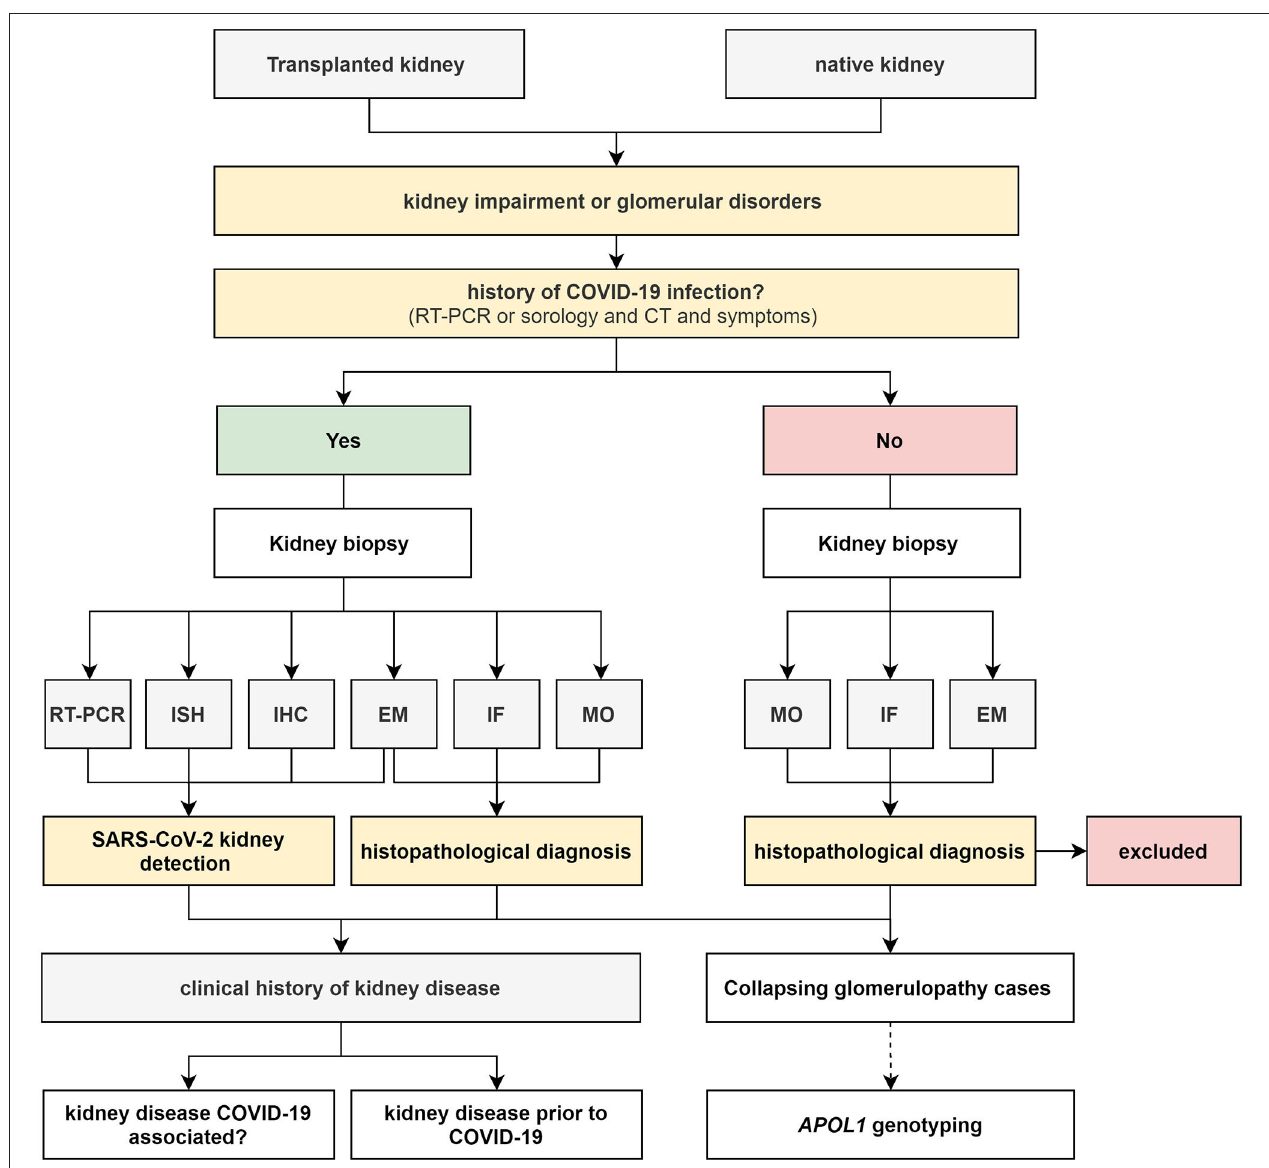
FIGURE 3 | Flowchart of the collection and processing of living patients. RT-PCR (Reverse-Transcriptase Polymerase Chain Reaction); ISH ( in situ hybridization); IHC (immunohistochemistry); MO (light microscopy); IF (immunofluorescence); EM (electron microscopy).